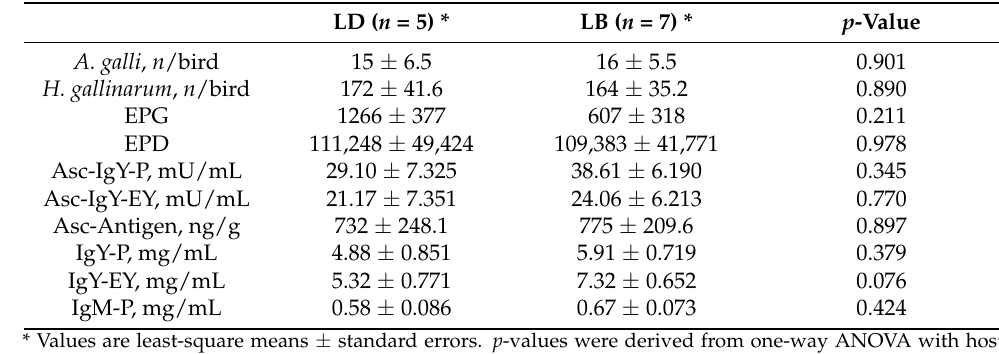
Table 1. Direct and indirect infection parameters measured at 6 wpi in hens of LD and LB genotypes following experimental co-infection with A. galli and H. gallinarum